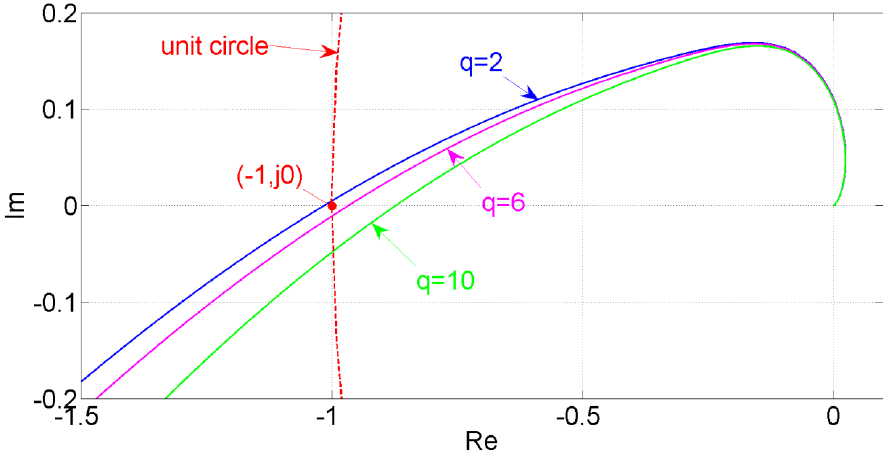
Figure 5. Nyquist plot for various flow rates q.